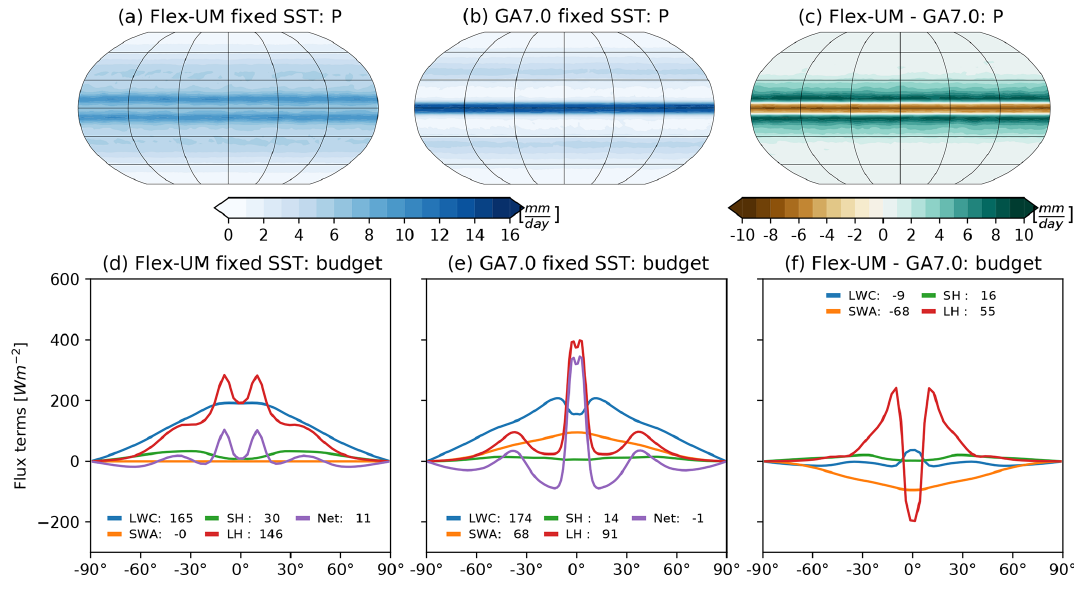
Figure 8. As in Fig. 6 but for precipitation ( P in mmd − 1 , a, b, c ) and the atmospheric energy budget (Wm − 2 , d, e, f